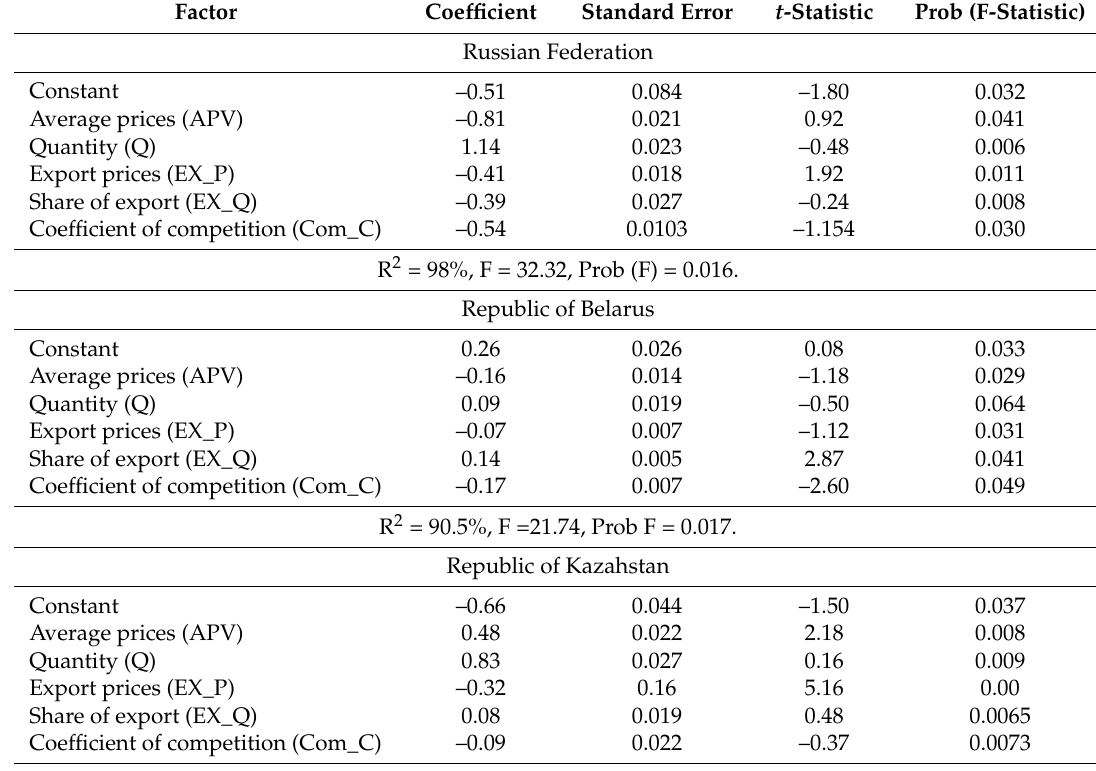
Table 3. Results of the regression analysis of competition factors of wheat in Russia, Kazakhstan, and Belarus from 2010 to